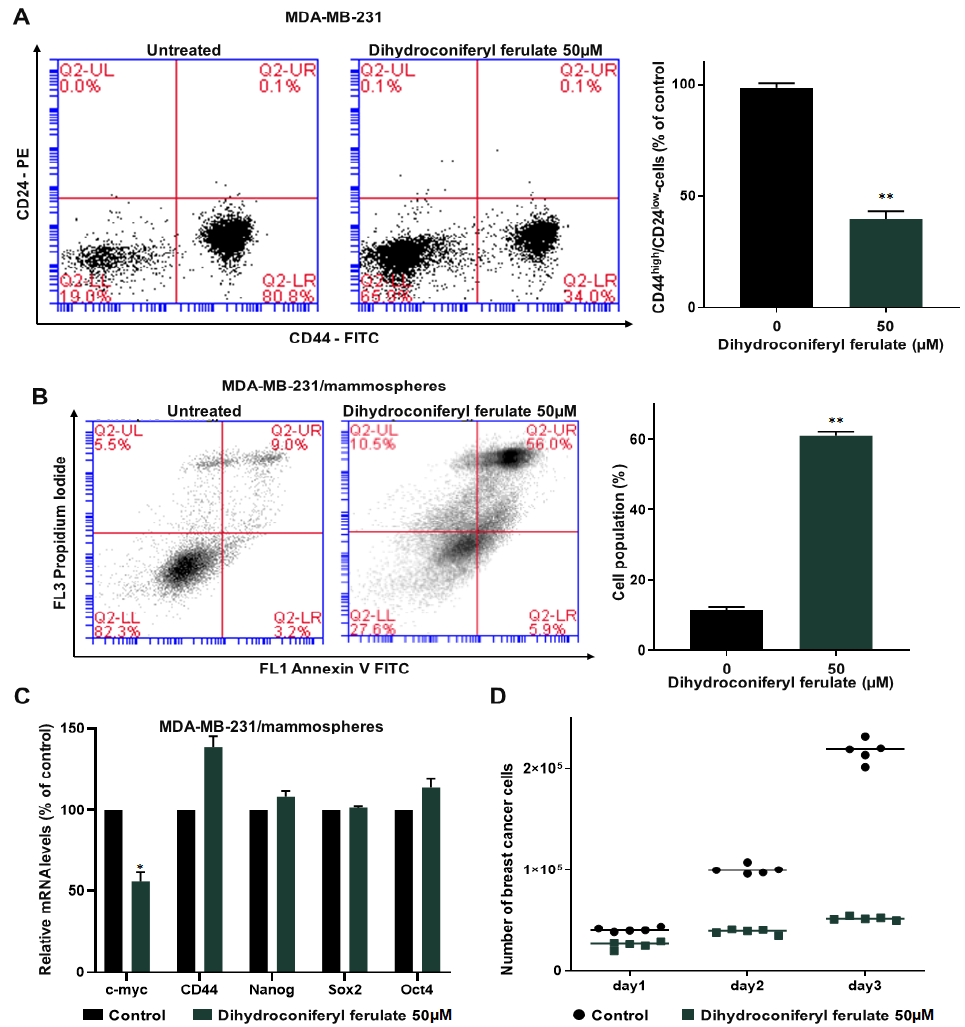
Figure 4. Dihydroconiferyl ferulate suppresses the subpopulations of CD44 high /CD24 low and the growth of mammospheres and induces apoptosis of mammospheres. ( A ) MDA-MB-231 cells were treated with dihydroconiferyl ferulate (50 µM) for 24 h. The CD44 high /CD24 low populations of breast cancer cells were examined by flow cytometry. ( B ) MDA-MB-231 tumorspheres were cultured for 5 days and then treated with dihydroconiferyl ferulate (50 µM) for 48 h. Tumorspheres were segre- gated into single cells and apoptosis was measured with an Annexin V/PI assay kit. ( C ) Transcripts for the CSC markers, Oct4, CD44, Sox2, c-myc, and Nanog, were examined in mammospheres treated with dihydroconiferyl ferulate using gene-specific primers by qRT- PCR (Table S1). β -actin was used as a control. ( D ) Dihydroconiferyl ferulate suppresses mammosphere growth. Mam- mospheres treated with dihydroconiferyl ferulate were segregated into single cells and an equal number of cells were seeded into 6 cm culture dishes. The cells were counted at 24, 48, and 72 h. Representative data were collected and represent the mean ± standard deviation; * p < 0.05, ** p < 0.01 vs. control.